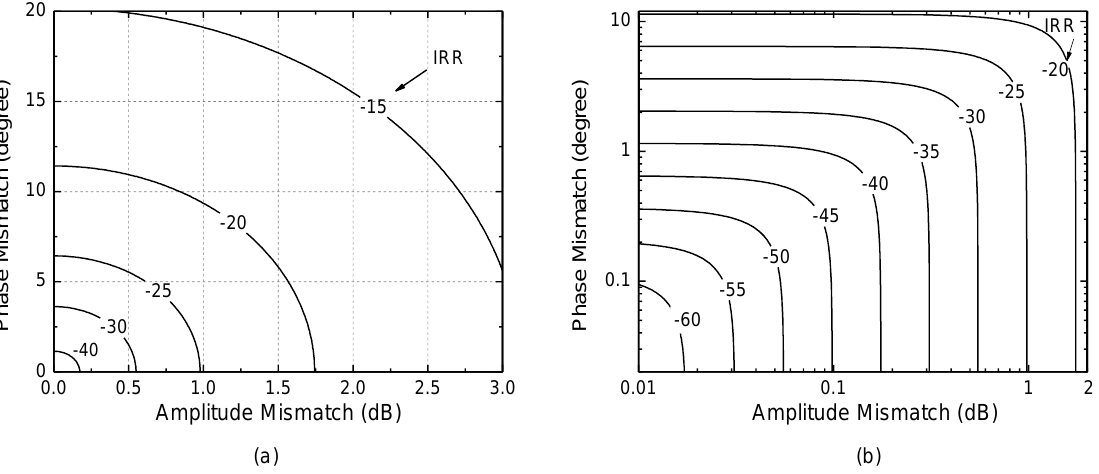
Figure 1. Theoretical image rejection ratio (IRR) with respect to the amplitude and phase mismatches. ( a ) x - and y -axis in linear scale; ( b ) x - and y -axis in logarithmic scale. Figure 1a,b are drawn by using the same data set, but Figure 1a is drawn with x - and y -axis in linear scale, whereas Figure 1b is drawn with x - and y -axis in logarithmic scale. The logarithmic scale plot of Figure 1b better exhibits the relationship in the low IRR (< − 40 dB) region. In addition, the logarithmic scale plot newly exhibits an